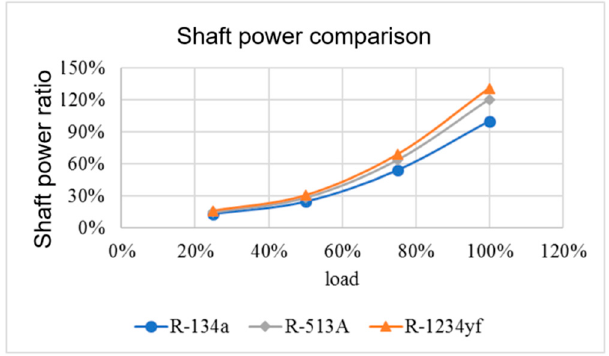
Figure 13. Comparison diagram of shaft power of refrigerants .